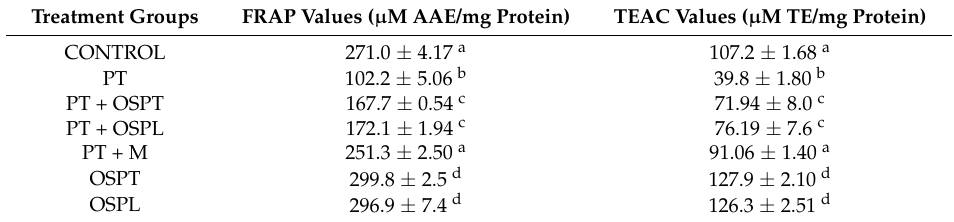
Table 3. The effect orange fleshed sweet potato extracts on antioxidant capacity (FRAP and TEAC